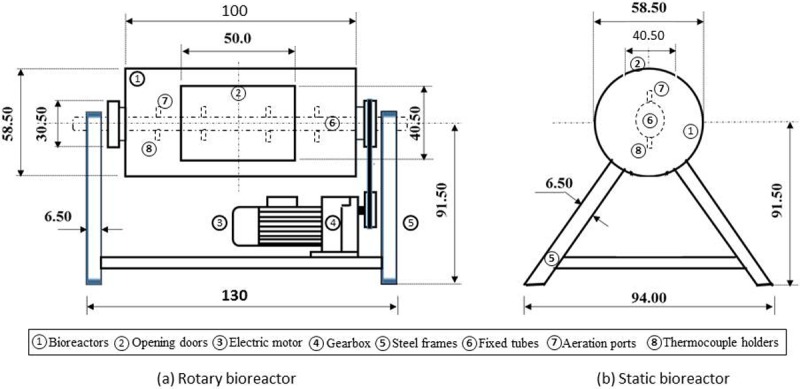
Schematic diagram showing the constructed (a) rotating bioreactor and (b) static bioreactor systems; dimensions in cm, not to scale.